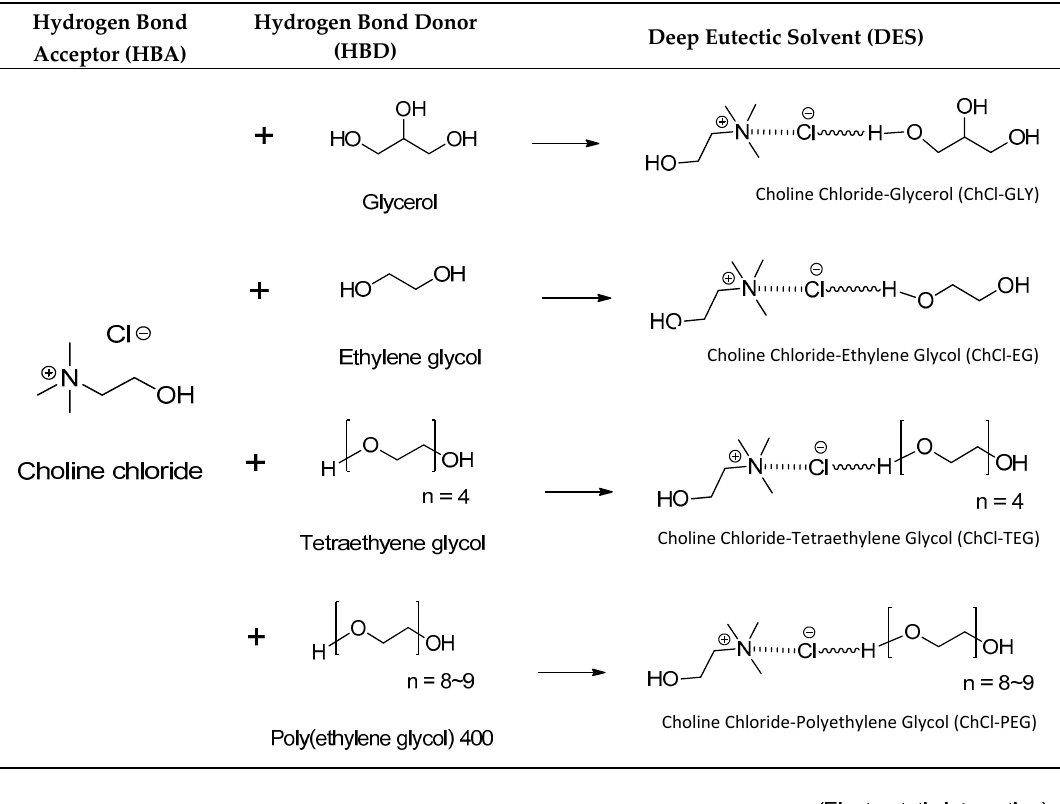
Figure 1. Reactions involved in the preparation of DES.